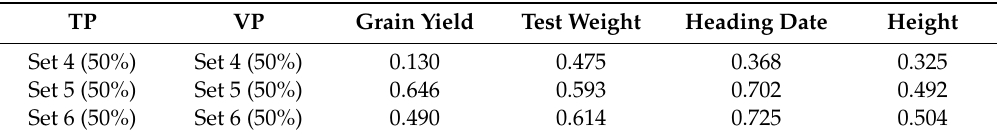
Table 3. Prediction accuracy for wheat grain yield (t ha − 1 ), test weight (kg hL − 1 ), heading date (days after 1 January) and height (cm). TP = training population; VP = validation population. TP is formed by 50% of lines of each family; all families are part of TP and VP.